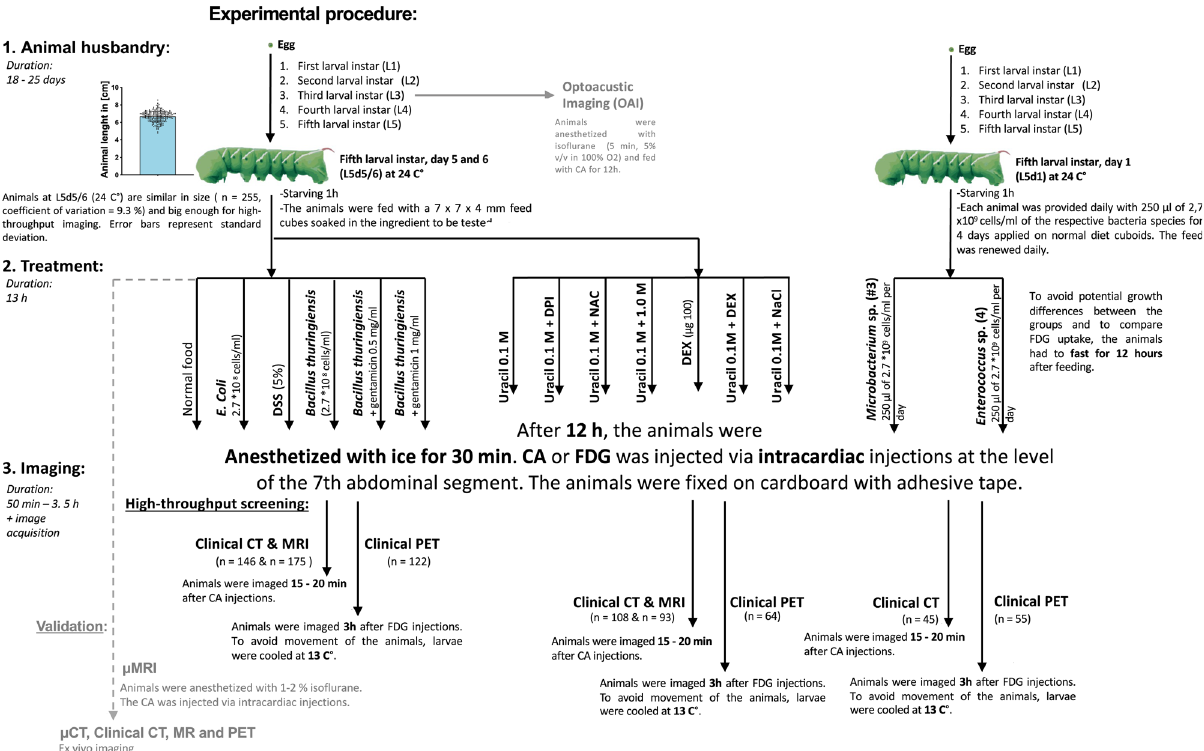
Fig.10|ExperimentalprocedureofCT,MRI,andPETimagingusedinthisstudy. BarchartsrepresentmeanandSD.Everydatapointrepresentsasingleanimal.Source data are provided as a Source Data fi